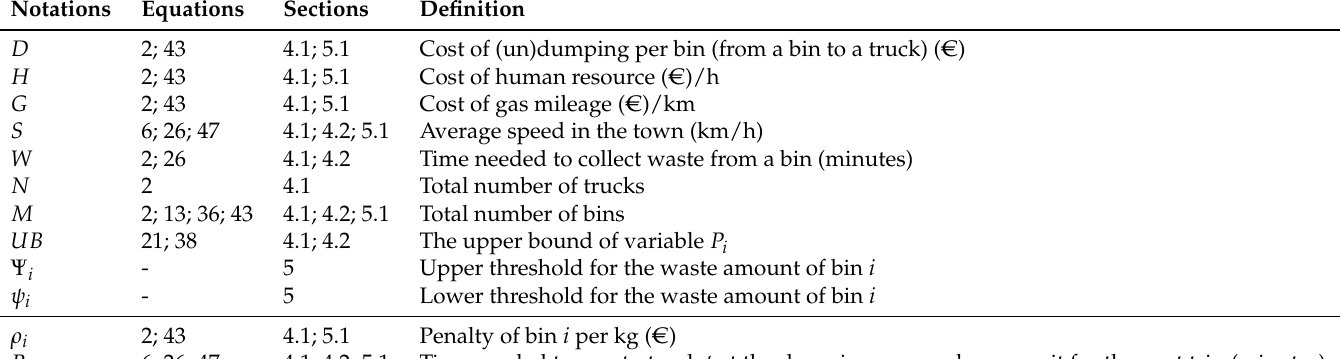
Table 1. Basic notations used in the system description. Notations are grouped into three categories: Constants, inputs and